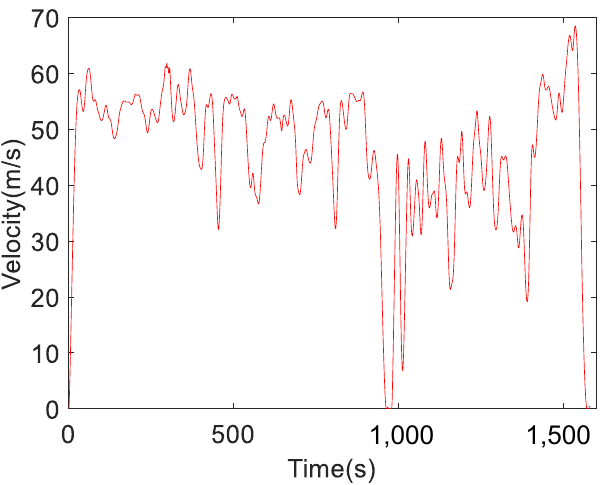
Figure 10. Constructed driving cycle of fuel cell logistics vehicle.